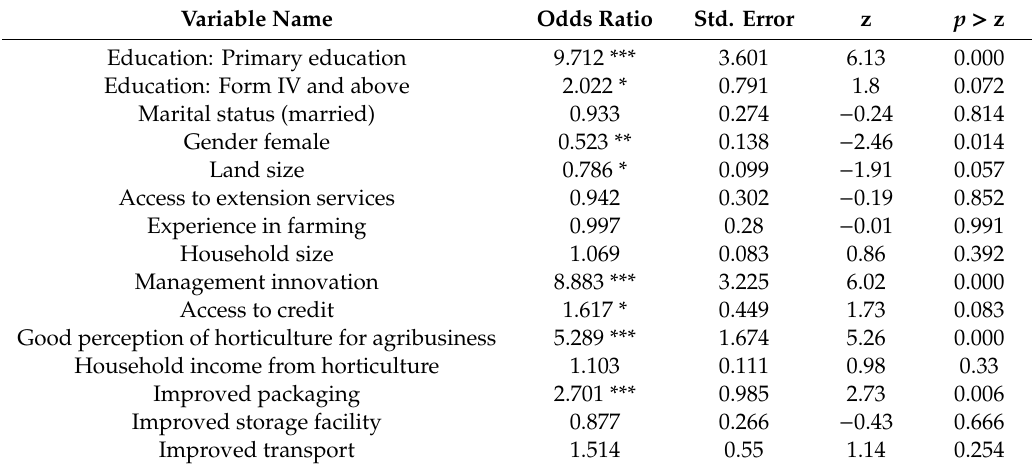
Table 3. Ordered logit model used to estimate factors influencing male and female youth involvement in horticulture